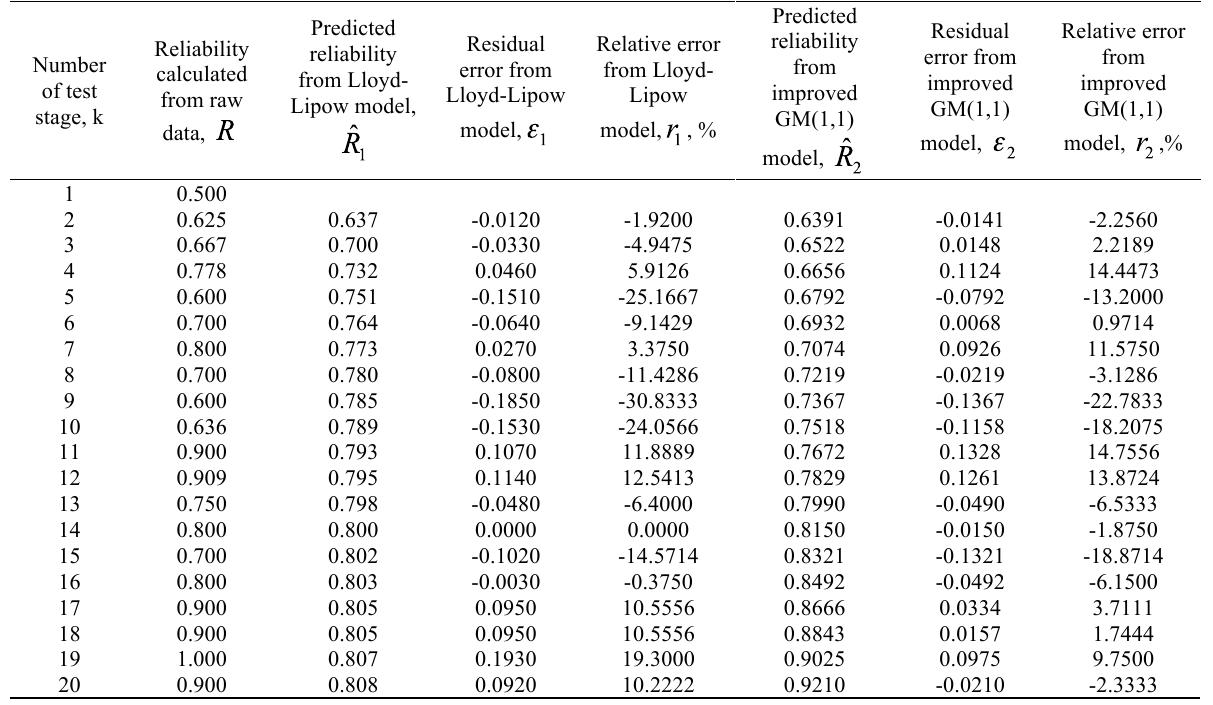
Table 2. Relative errors of predicted reliability values from the Lloyd-Lipow model and the improved GM(1,1)